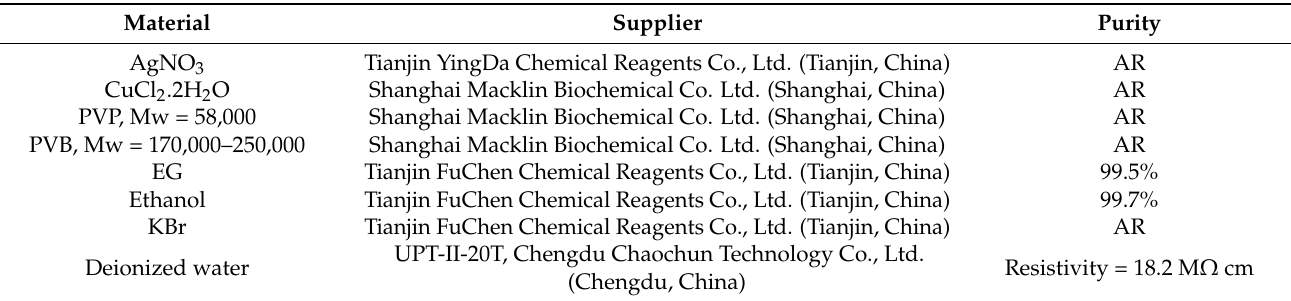
Table 1. The suppliers and purity of the